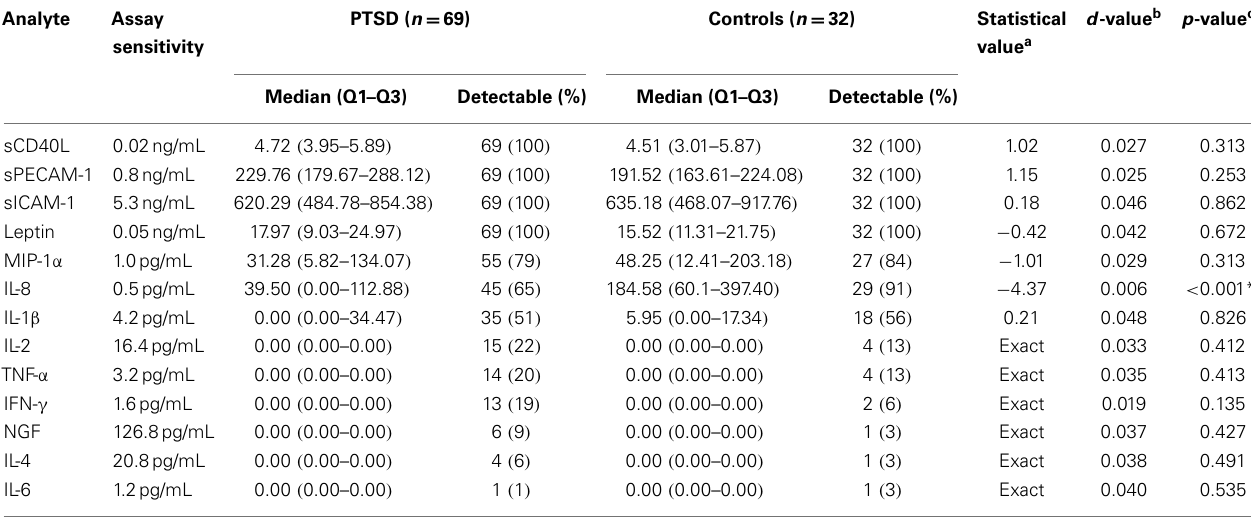
Table 3 | Comparison of multiplex assay analytes between PTSD patients and controls at the first assessment . Analyte